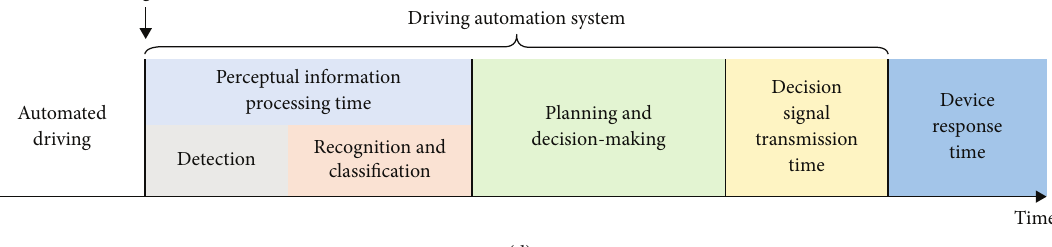
Figure 2: Decomposed perception-brake reaction time of actors: (a) L 0 − and L 0 + ; (b) L 1 and L 2; (c) L 3; (d) L 4 and L